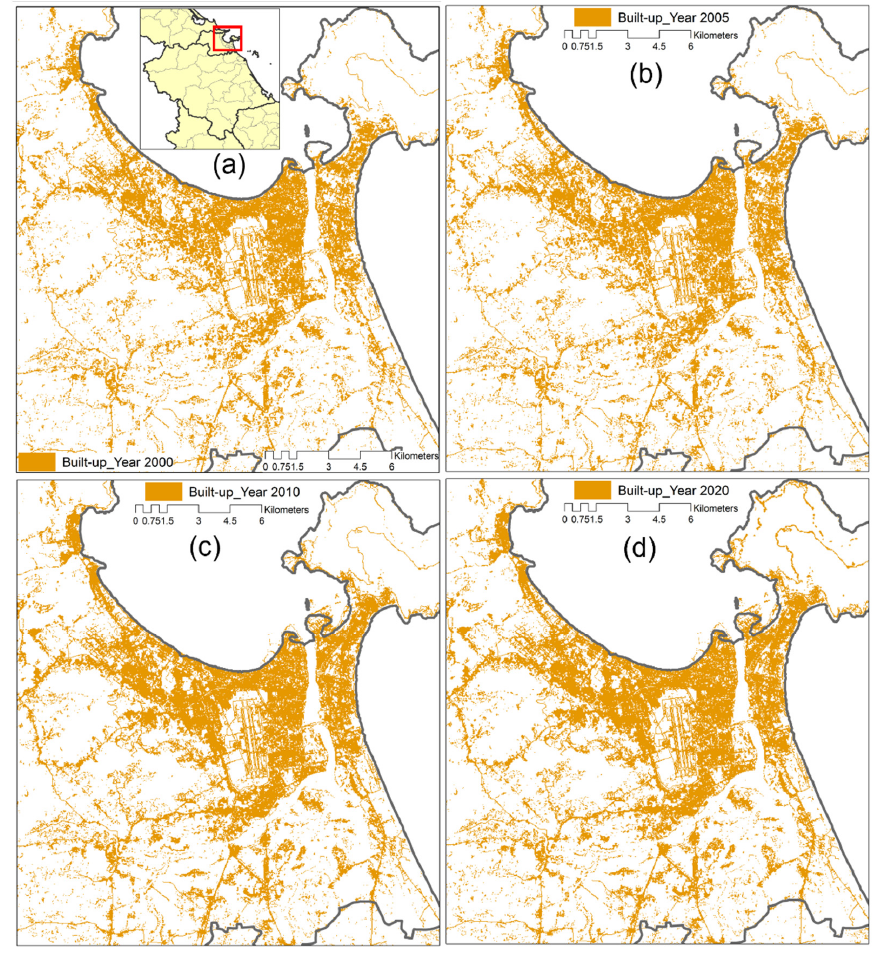
Figure 4. The built-up area distribution in ( a ) 2000, ( b ) 2005, ( c ) 2010, and ( d ) 2020 in Da Nang city.